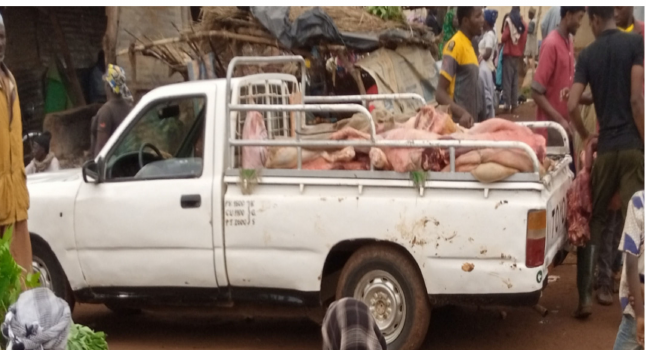
Figure 3. Traditional transport of carcasses from slaughterhouses to meat distribution points.